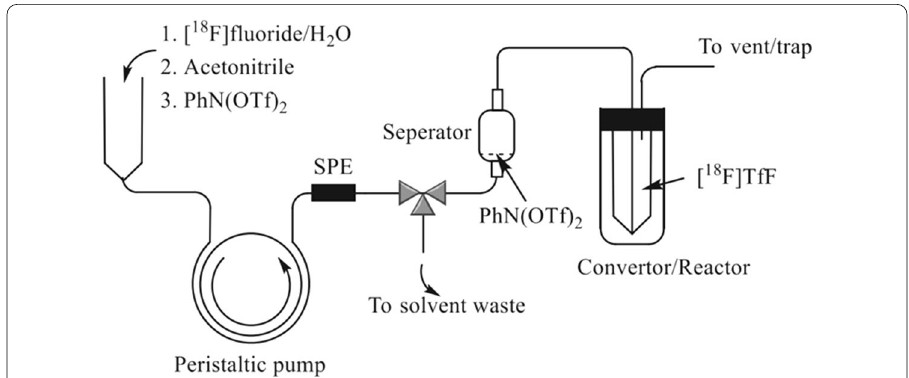
Fig. 2 Schematic illustration of the continuous‑flow generation process of [ 18 F]TfF (With permission from Zhou and Katzenellenbogen (2021) by Copyright Clearance Center’s